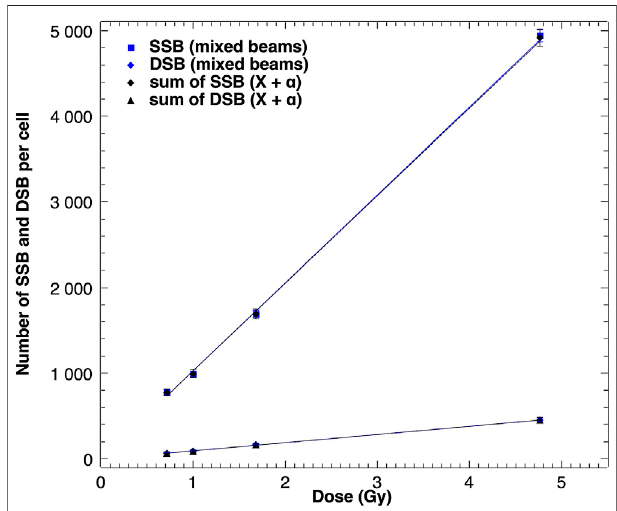
FIGURE3| ModelednumbersofSSBandDSBinducedinacellnucleus by mixed beams of alpha particles and X-rays and sums of SSB and DSB induced by both radiation types given independently. Error bars indicate standard deviations.